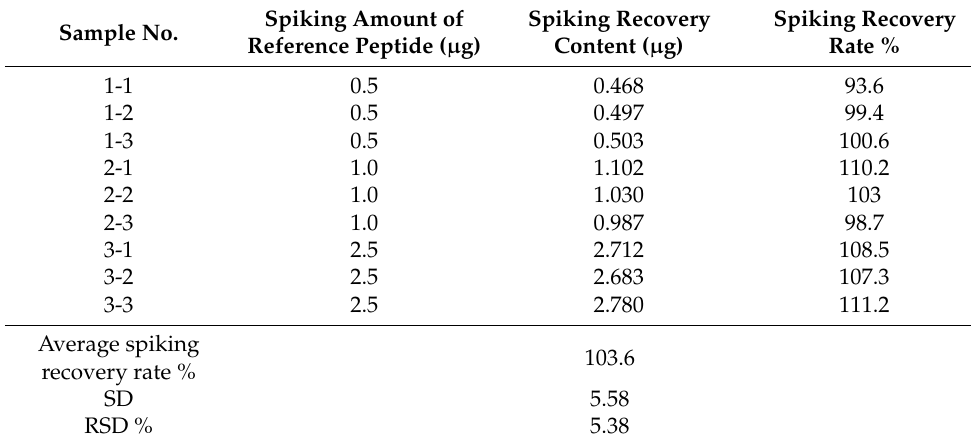
Table 5. Spiking recovery rate of the quantification method in the blank